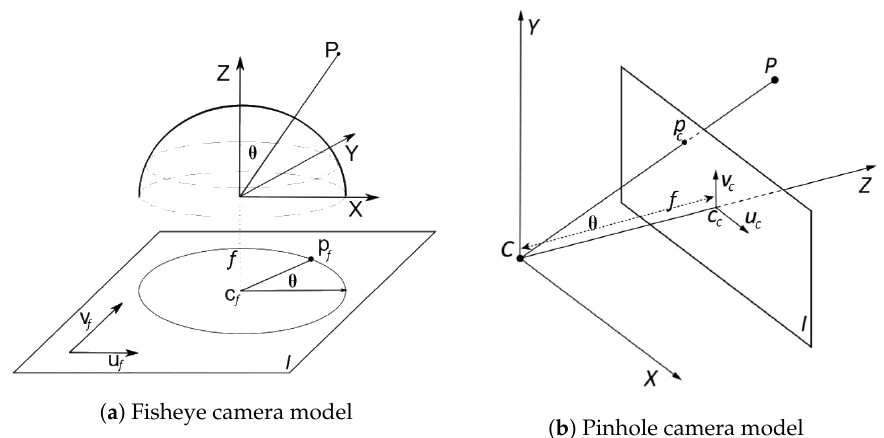
Figure 2. Comparative between camera